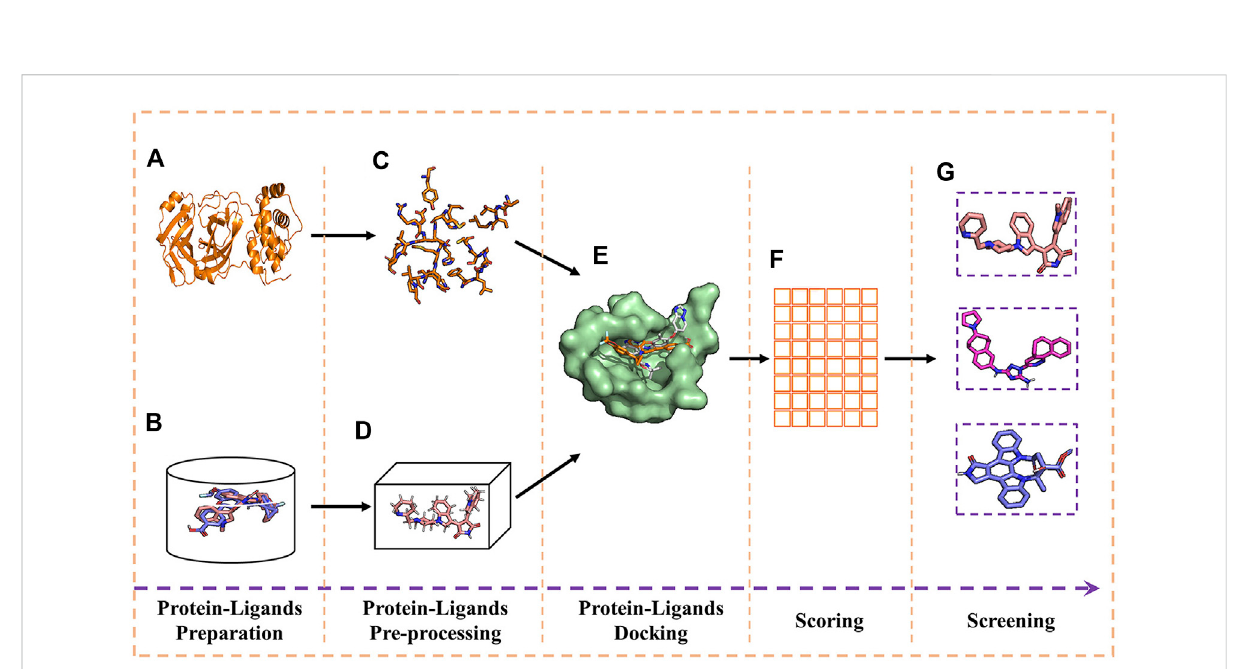
FIGURE 3 Experimental process of molecular docking and virtual screening. (A) Receptor; (B) ligands; (C) receptor pre-processing; (D) ligand pre- processing; (E) docking of receptor and ligands; (F) table of free energy score; and (G) virtual screening for the docking